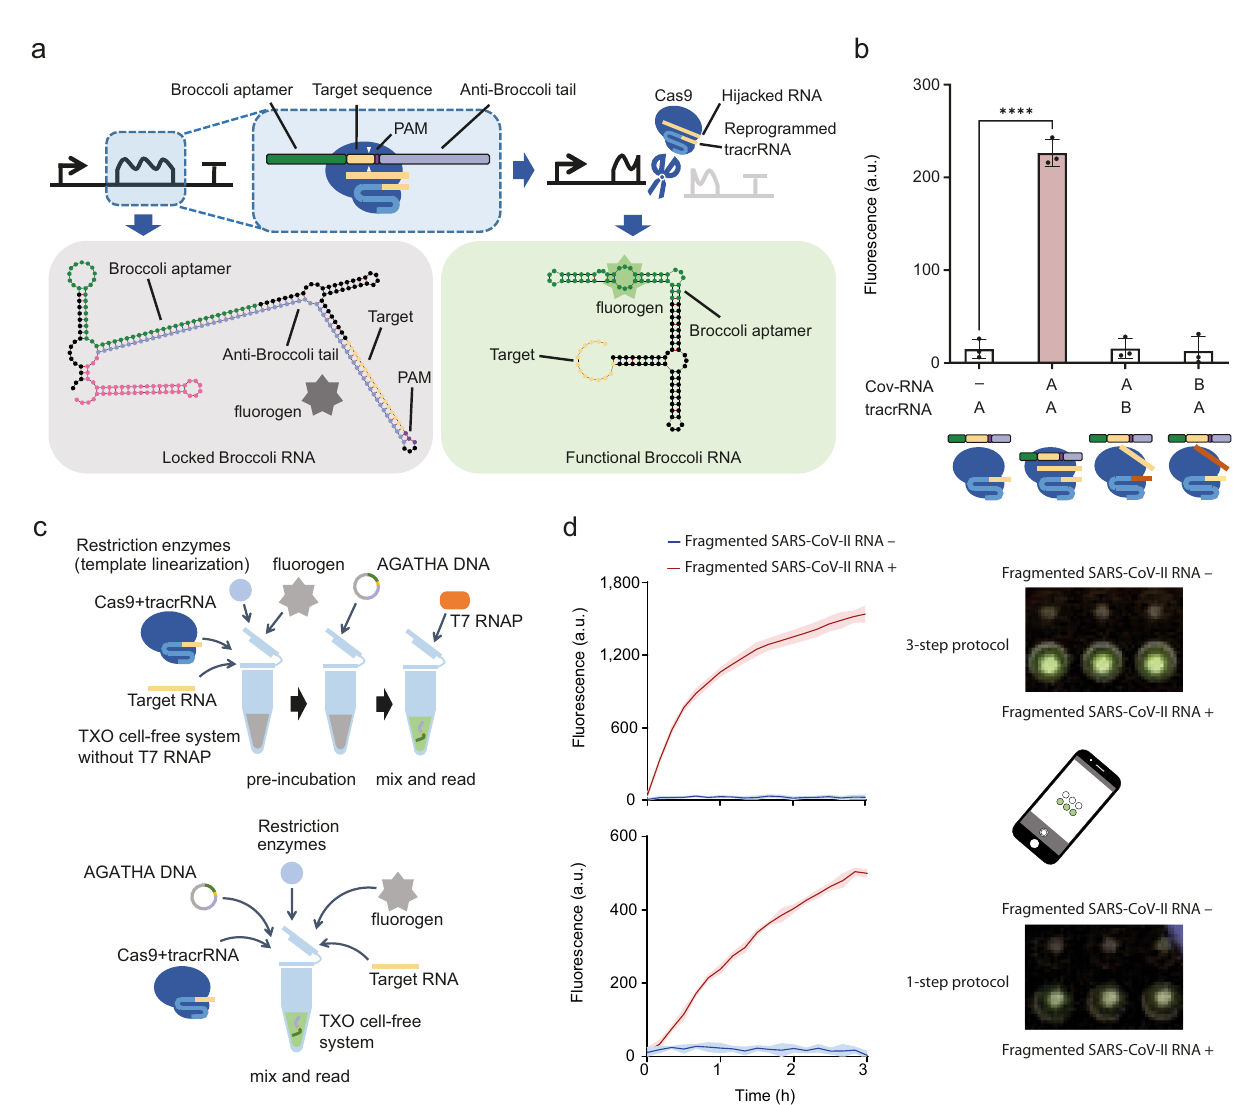
Fig. 5 Atypical gRNA-activated Transcription Halting Alarm (AGATHA) system. a Schematic showing the design and mechanism of AGATHA sensor. In the box surrounded by the dashed line, the bordered green bar indicates the Broccoli RNA sequence, and the bordered yellow bar indicates the CRISPR target DNA site paired with the target RNA. The bordered dark purple bar indicates PAM, and the bordered light purple bar indicates an anti-Broccoli tail with an inverted repeat sequence of the Broccoli. The two white triangles mark the position where CRISPR/Cas9 cleaves the AGATHA reporter DNA; the borderless lines indicate gRNA molecules. The cartoon below shows the secondary structure of the RNA aptamer predicted by mfold Web Server 39 . The polygonal star is the fl uorogen, which is activated when binding to the Broccoli aptamer. The colors in the RNA structure diagram are consistent to those in the box above, with the pink segment indicating the T7 terminator. b Speci fi city test of AGATHA. Two different viral RNA fragments (A and B) from the SARS-CoV-2 virus and the corresponding reprogrammed tracrRNAs were used to test the speci fi city of AGATHA. The T7 in vitro transcription system was used on addition of 5ng μ L − 1 AGATHA DNA, 50nM synthetic CoV-SARS-2 RNA fragment, 50nM synthetic tracrRNA and 50nM SpCas9. Data were collected 3h following incubation. Statistical difference was determined by a two-tailed t test: R1, p <0.0001, t = 20.57. Error bars, mean values ± s.d. ( n = 3). c Schematic showing the assay procedure of AGATHA to detect target coronavirus (SARS-CoV-2) RNA fragments. The reaction was carried out either with (top) or without (bottom) pre-incubation (see METHODS). d Dynamic output responses (left) and mobile phone images (right) of the AGATHA sensor responding to SARS-CoV-2 RNA fragment with (top) or without (bottom) pre-incubation. Phone images were acquired at the end of the reactions (see METHODS). The T7 in vitro transcription system is the same as in b . Error bars, mean values ±s.d. ( n = 3). a.u., arbitrary units. p value summary: **** p value<0.0001, 0.0001<*** p value<0.001, 0.001<** p value<0.01, 0.01<* p value<0.05, p value ≥ 0.05: ns. Source data are provided as a Source Data fi